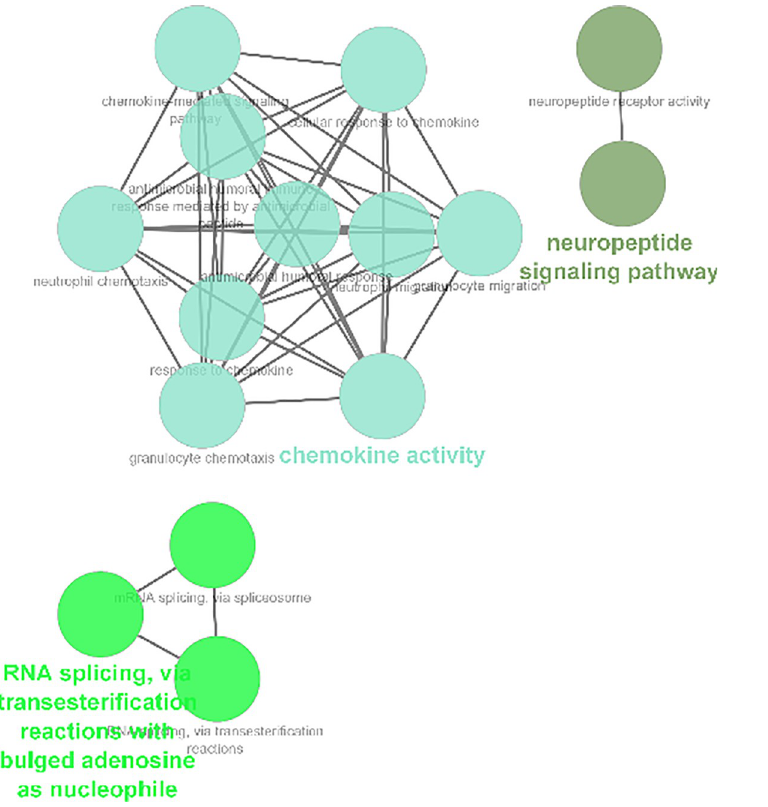
Fig 12. ClueGO annotation results based on biological process